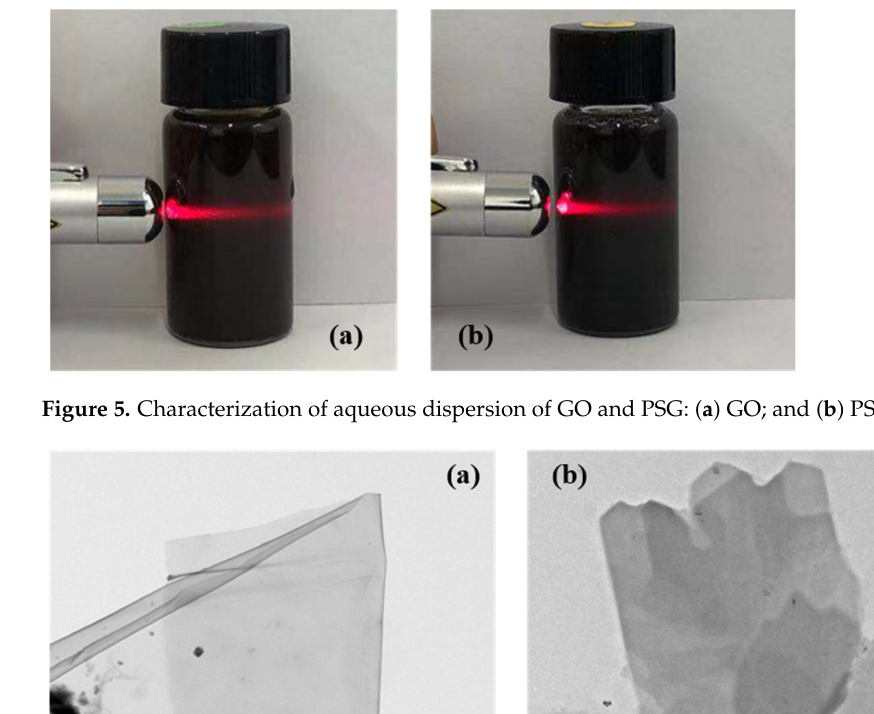
Figure 4. TG-DTA curve of GO and PSG.